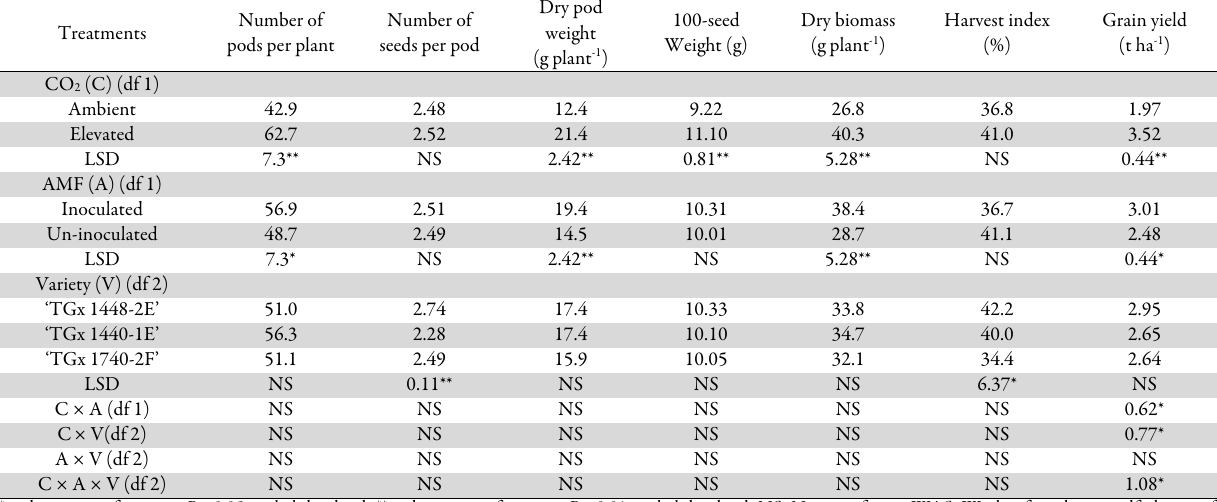
Table 4. Effect of CO 2 enrichment and AMF inoculation on number of pods, number of seeds per pod, dry pod weight, 100-seed weight, dry, total dry biomass yield per plant, harvest index and grain yield ha -1 of soybean varieties at 90 % harvest maturity (Field experiment) Treatments